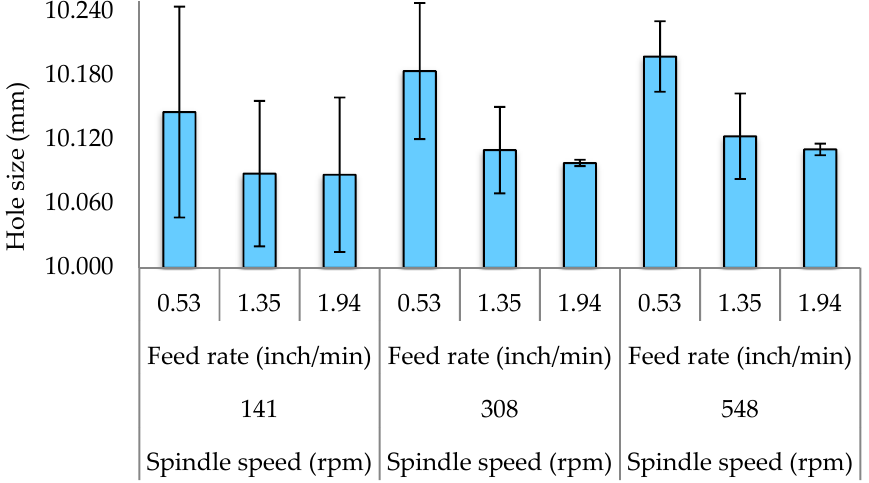
Figure 2. Deviation of hole size.